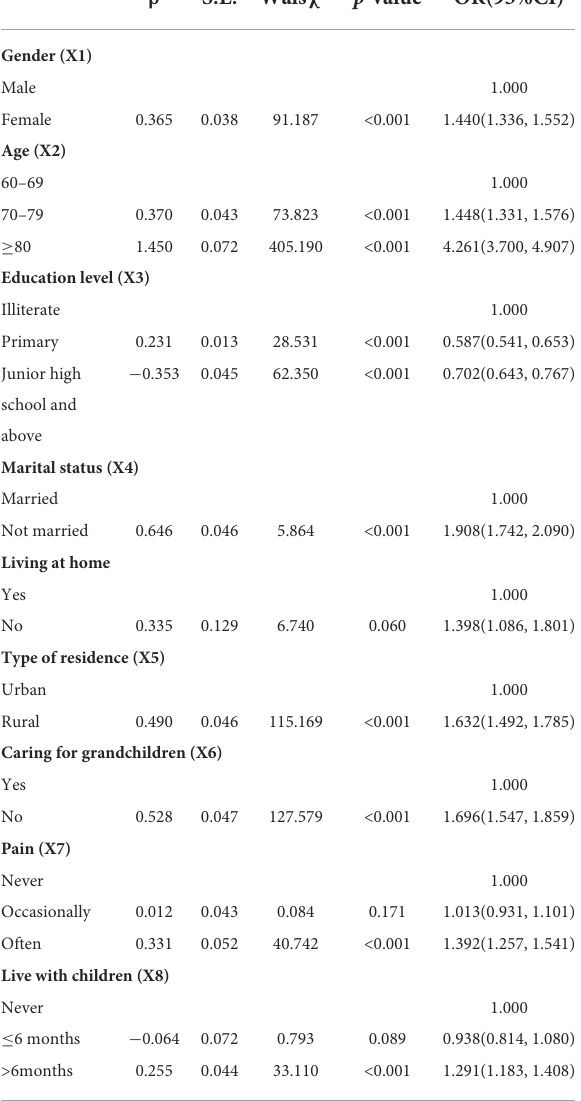
TABLE 2 Logistic regression analysis of factors correlating with cognitive impairment among elderly Chinese individuals with different